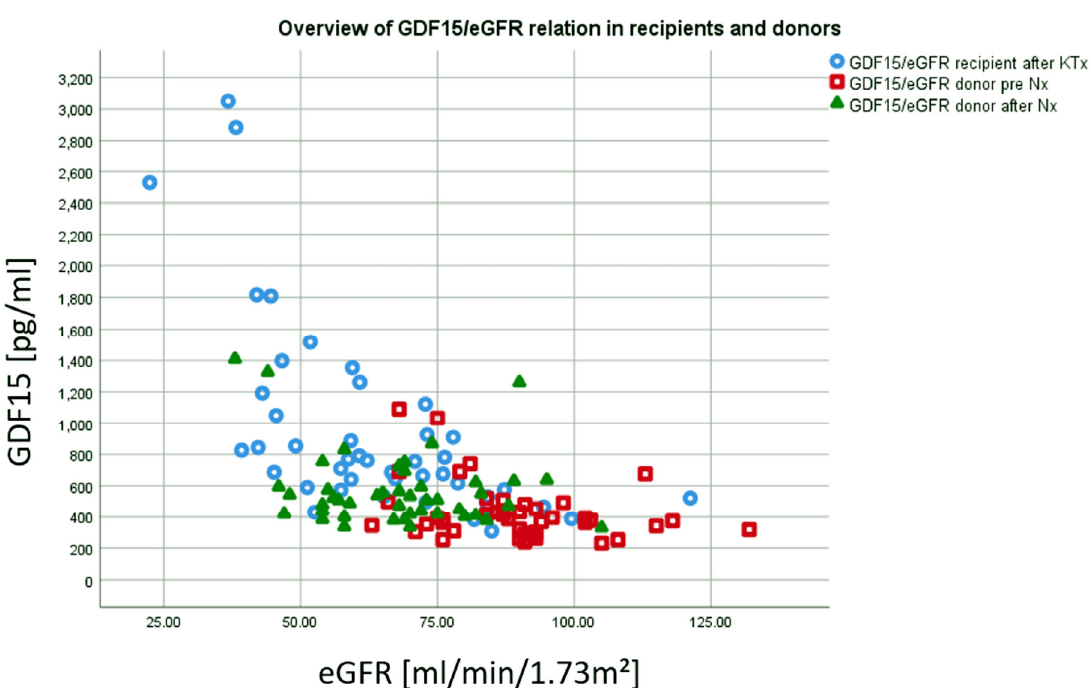
Figure 4. Recipients one year after KTx showed highest GDF15 values and lowest eGFR (blue). In contrast, donors´ after Nx showed lower GDF15 values and higher eGFR after Nx (green). Whereas eGFR is noticeably decreased compared to pre Nx, GDF15 values are only slightly elevated compared to pre Nx (red).